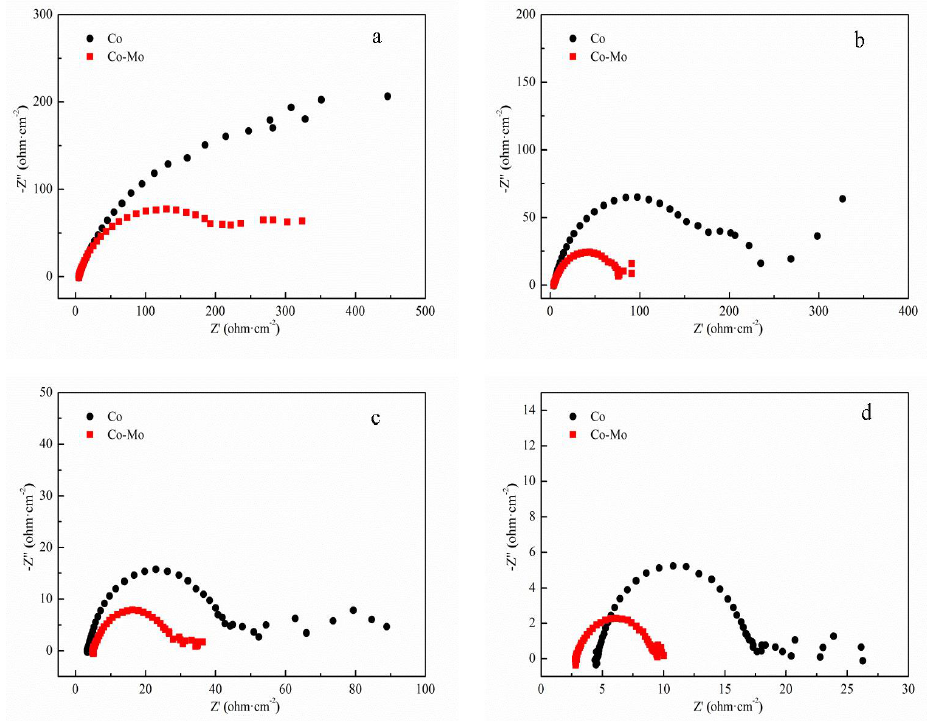
Figure 8. Nyquist plots of electroplating plating baths in different deposition potentials: (( a ) − 950 mV; ( b ) − 1050 mV; ( c ) − 1150 mV; ( d ) − 1250